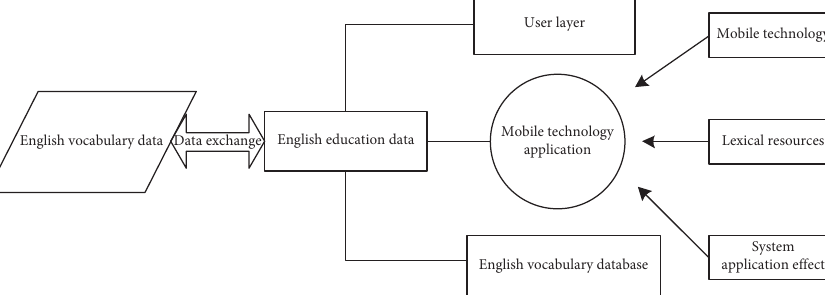
Figure 1: Basic framework of the college English vocabulary teaching system based on mobile technology.